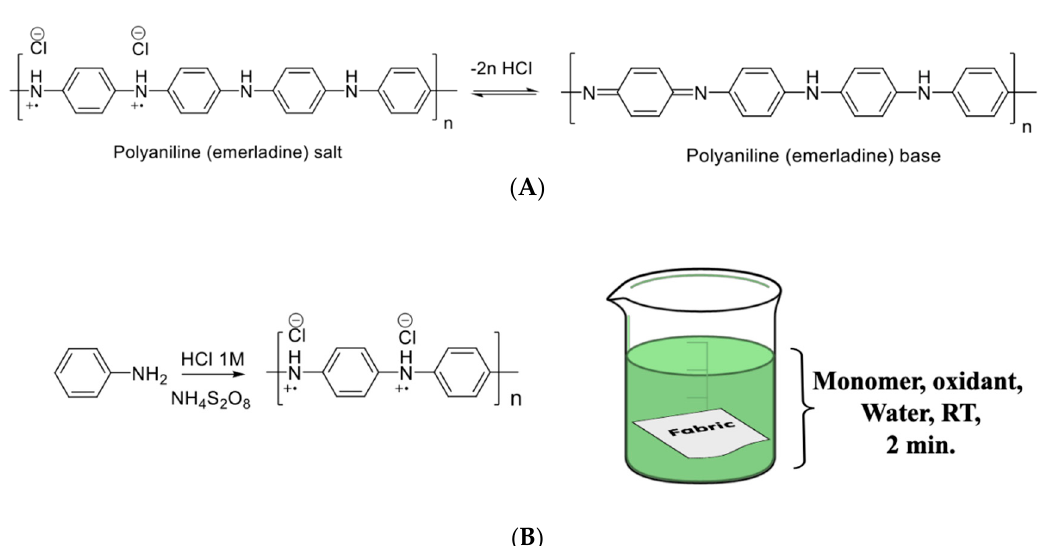
Figure 1. Neat and PANI-coated 50:50 PET:viscose fabrics at different PANI